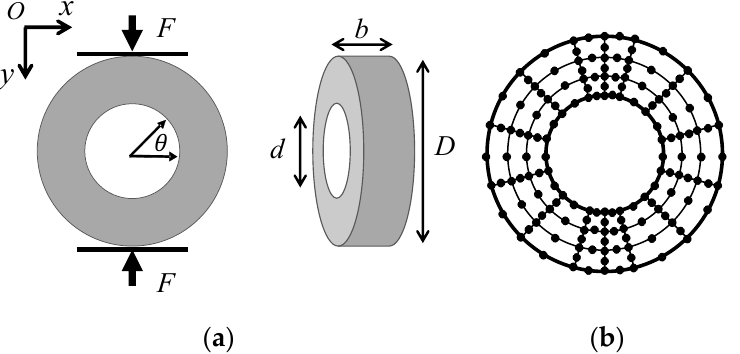
Figure 10. Diametrical compression test diagram of the aluminum ring ( a ) and meshing scheme in Q8-DIC ( b ) .